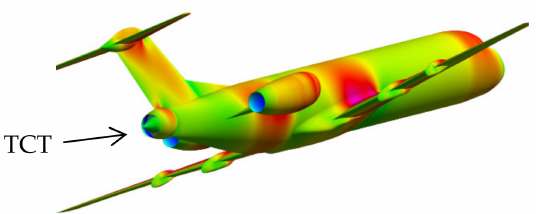
Figure 1. GKN/Fokker 100 tail cone thruster (TCT) concept and pressure distribution over the whole aircraft computational fluid dynamics